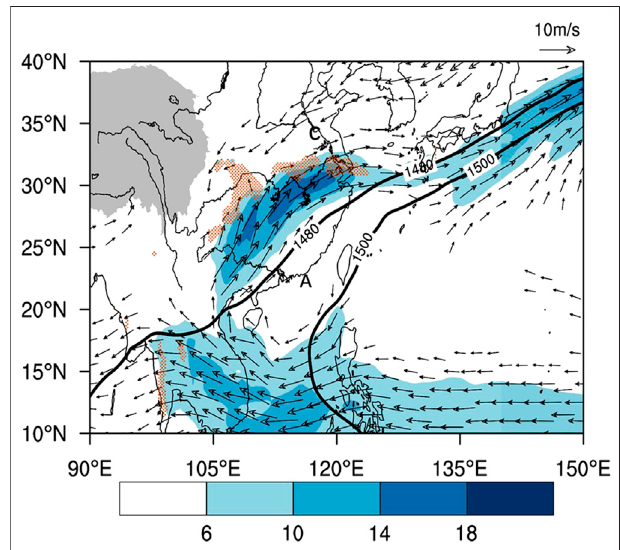
FIGURE 7 | Horizontal wind fi eld anomaly (arrow, unit: ms − 1 ), water vapor fl ux anomaly (colored, unit: kg m − 1 s − 1 hPa − 1 ) and water vapor fl ux divergence anomaly (dotted area < − 1.5, unit: 10 − 7 kg m − 2 s − 1 hPa − 1 )